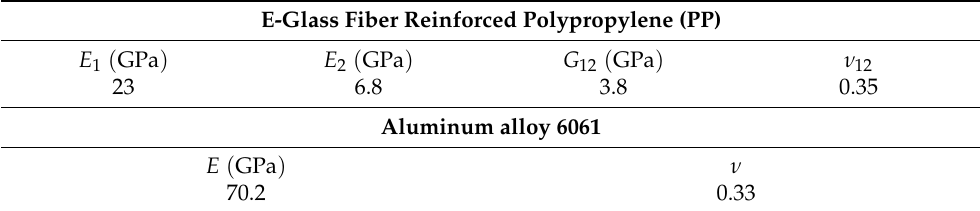
Table 2. Mechanical properties of E-glass fiber-reinforced polypropylene (PP) and Aluminum alloy